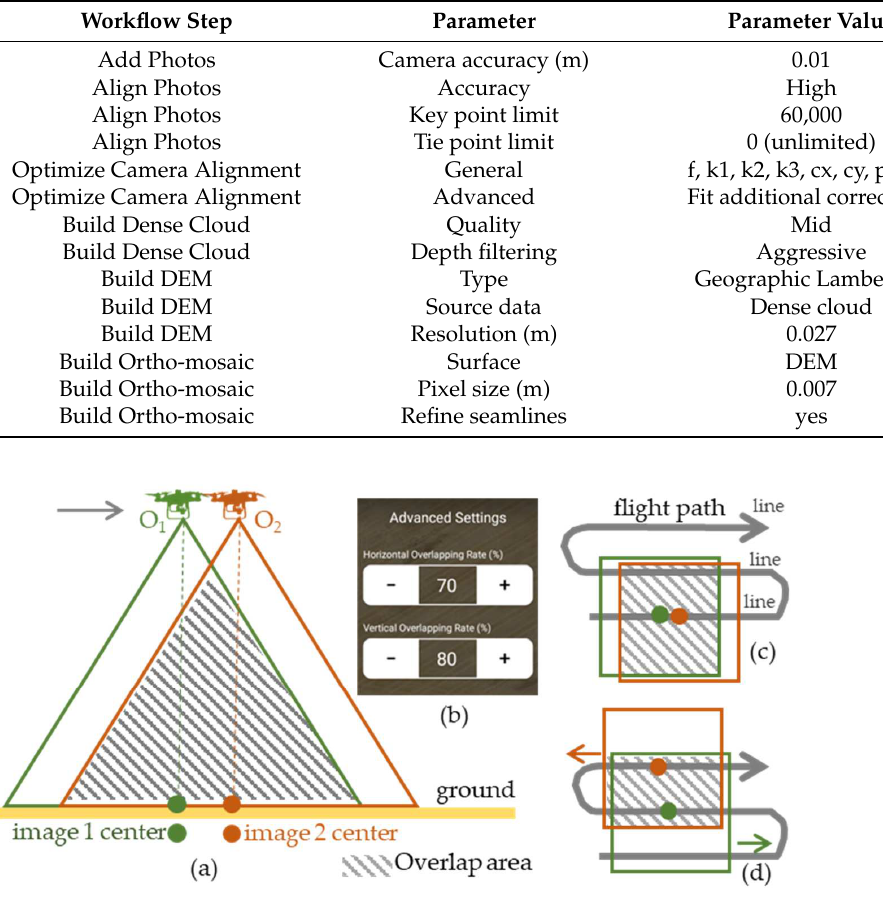
Figure 20. Overlap rate definitions: ( a ) forward overlap (vertical) side view; ( b ) GS RTK dialog box for overlapping choice; ( c ) forward overlap top view; ( d ) side overlap top view. Table 4. The 12 reconstructions that were computed with Agisoft